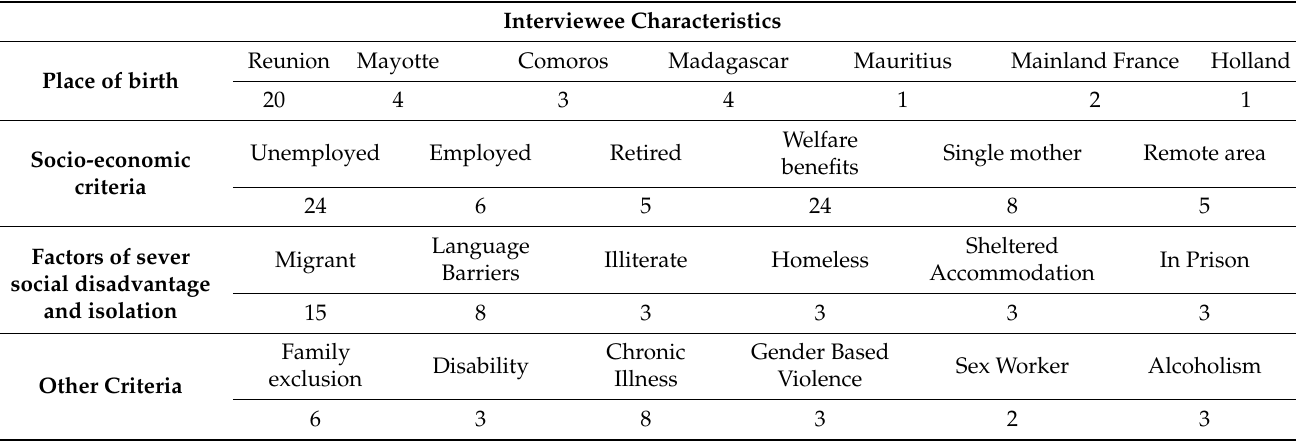
Table 1. Women Interviewees’